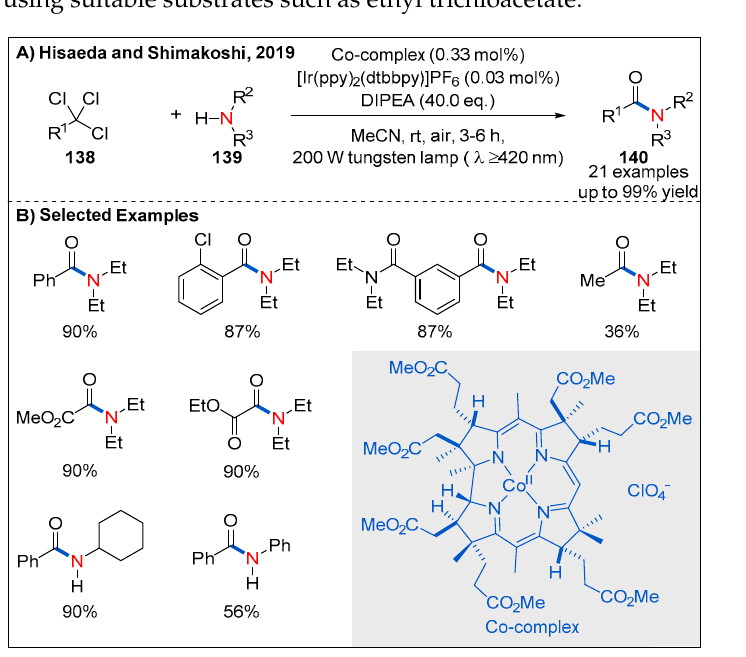
Figure 41. Visible-light-driven amide synthesis from trichlorinated compounds.